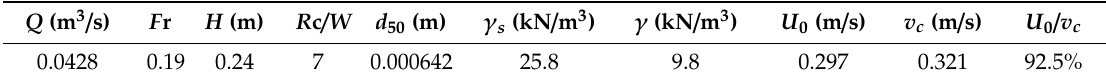
Figure 2. Details of experiment setup: ( a ) plan view parameters related to the experimental flume and arrangement of the cross-sections; ( b ) experimental flume; ( c ) test lines ( S 29.5); ( d ) groyne. Table 1. Experimental parameter